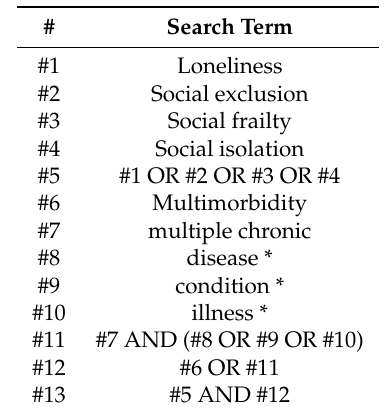
Table 1. Search strategy